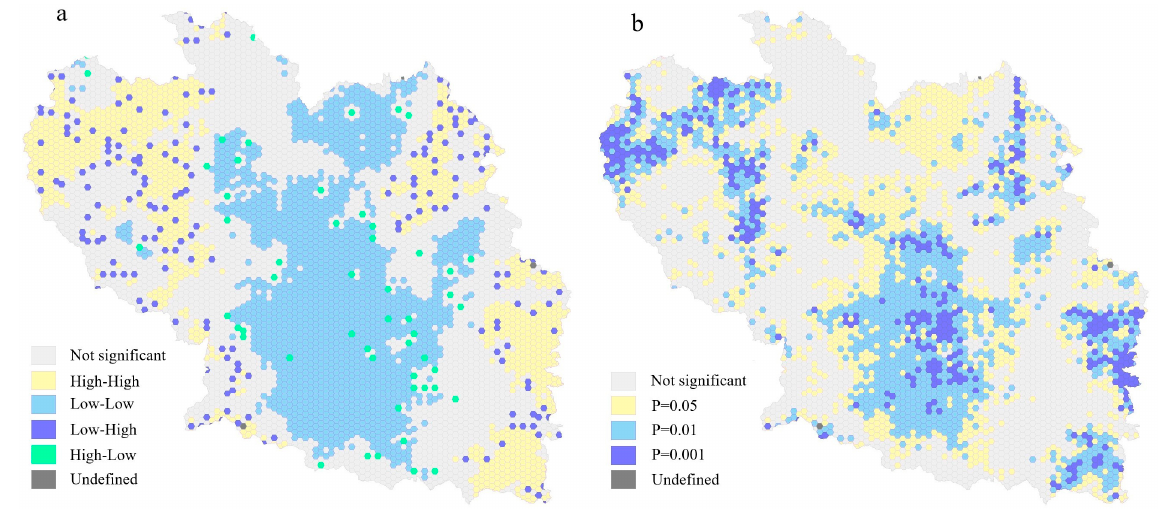
Figure 12. Spatial analysis of carbon stocks Lisa clustering ( a ) and p value distribution map ( b ).